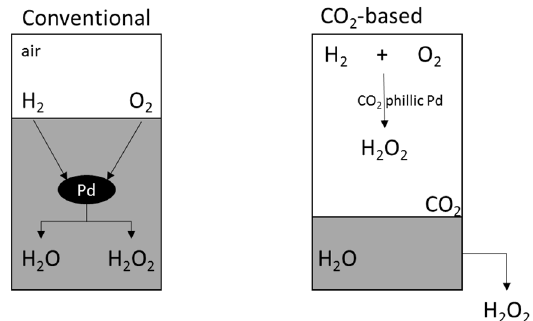
Figure 1. Comparison of direct synthesis of H 2 O 2 in conventional (aqueous solutions) and CO 2 with a modified CO 2 -phillic Pd catalyst (Figure taken from H â ncu and Beckmann [28]). Reprinted here with the kind permission of the Royal Society of